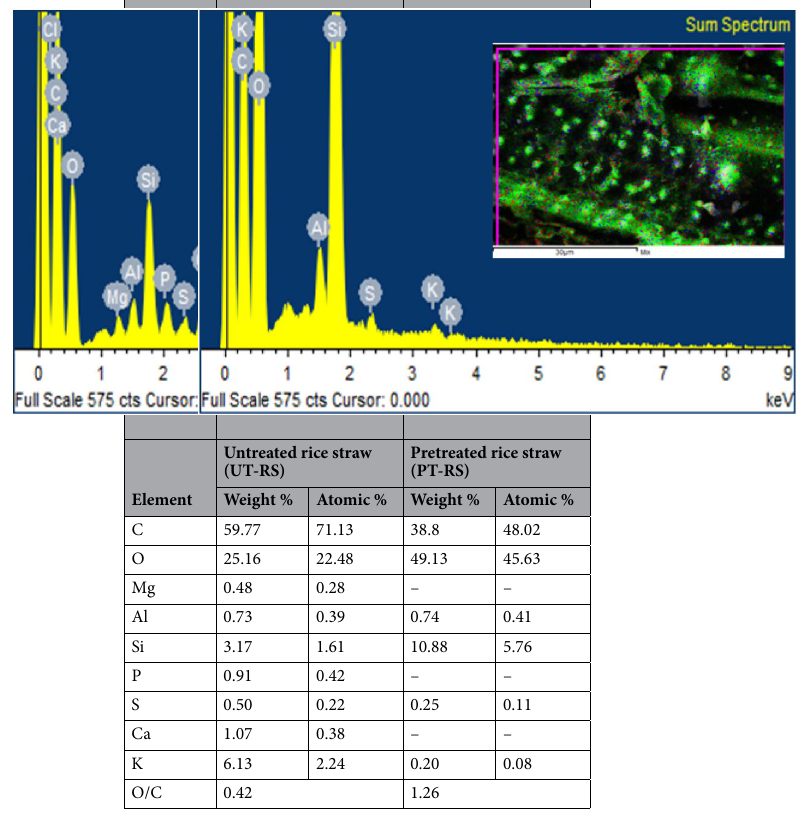
Table 2. Energy dispersive X-ray analysis of untreated (UT-RS) and pretreated rice straw (PT-RS) samples.